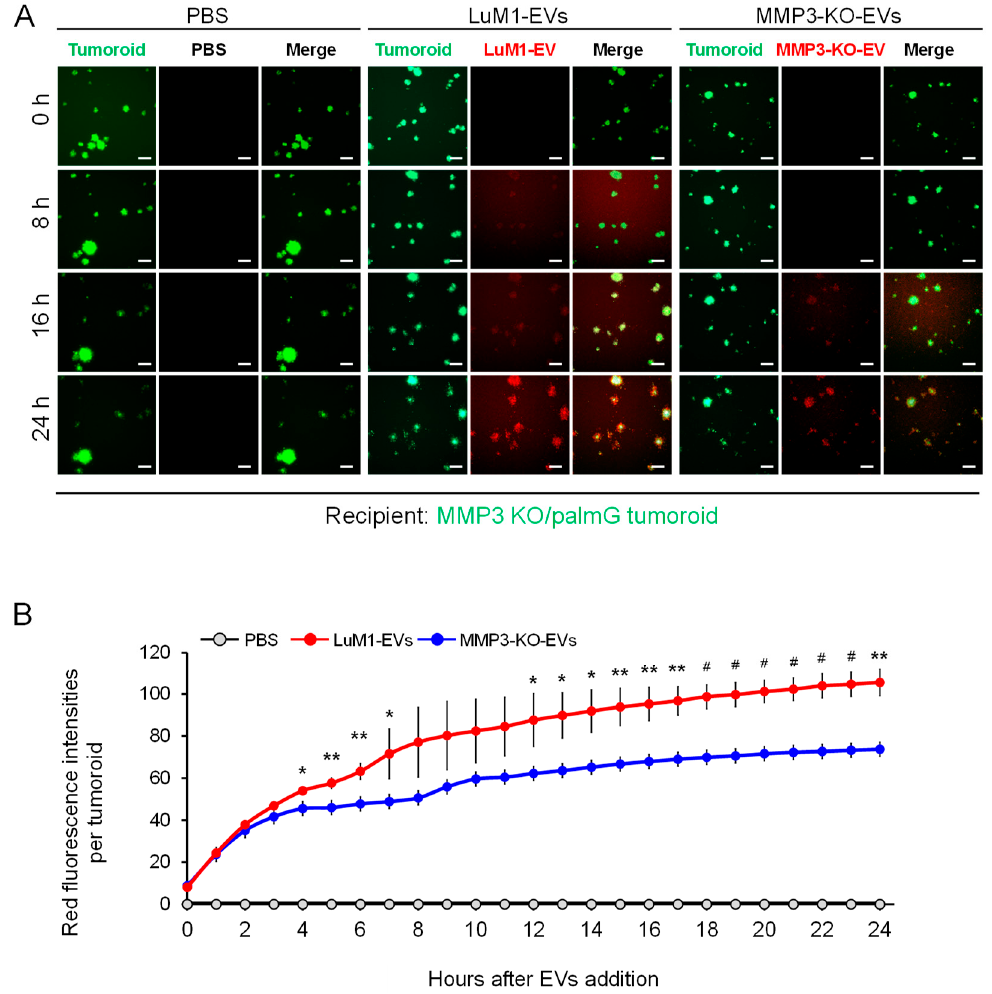
Figure 10. The Knockout of the MMP3 significantly decreased the transmissive potential of tumoroid-derived EVs. EVs were collected after 6 days from the culture supernatants of tumoroids that formed in ULA plates. EVs were fluorescently labeled with BODIPY TR Ceramide (red). The labeled EVs or PBS were added to the MMP3-KO / palmG (green) tumoroids at a concentration of 5 µ g / mL in the NCP-based 3D culture with the stemness-enhancing medium. The uptake of EVs was monitored over 24 h using the high contents screening (HCS) system. ( A ) Time-course imaging of EV uptake (red) by MMP3-KO / palmG tumoroids (green) for 24 h. Scale bar, 100 µ m. ( B ) Red fluorescence intensities of transmitted EVs in MMP3-KO / palmG tumoroids. The average fluorescence intensity of the PBS treatment group at time point 0 h was evaluated as background and subtracted from raw values. n = 3, * p < 0.05, ** p < 0.01, and # p < 0.001 (LuM1-EVs versus MMP3-KO-EVs).